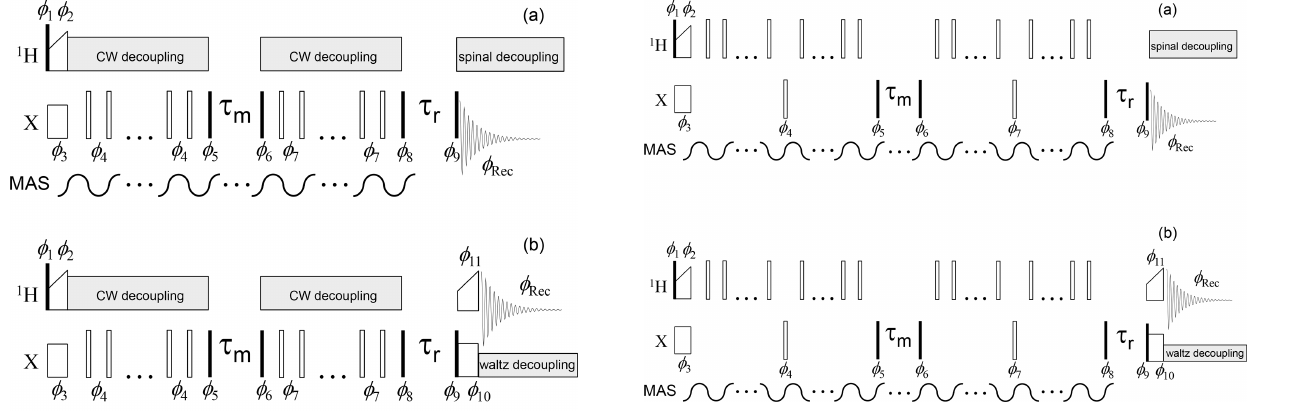
Figure 4. Dipolar CODEX pulse sequence for the direct (a) and indirect (b) signal detections. The denotations are the same as in Fig. 3. π pulses applied on the X channel are set in the middle of the de(re)phasing periods; therefore, the duration of these periods should be an even multiple of the MAS period. The phase cycle is identical to that shown in Fig. 3. The phases of the π pulses applied during the de(re)phasing periods on the 1 H channel have no critical